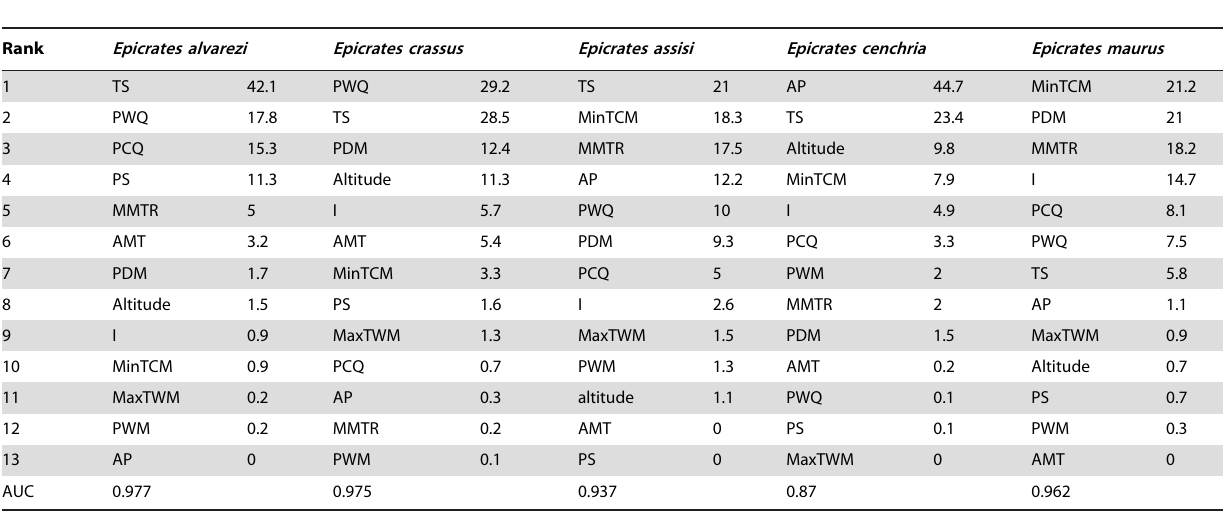
Table 1. Topographic and bioclimatic variables ranked according to their overall model contribution for continental species of the genus Epicrates